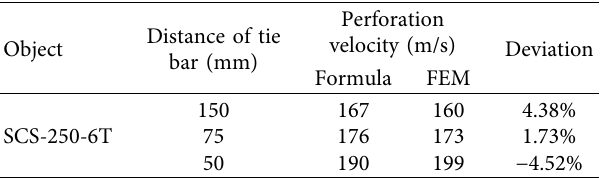
Table 7: Perforation velocity comparison of SCS-250-6T with a different distance of tie bar for blunt